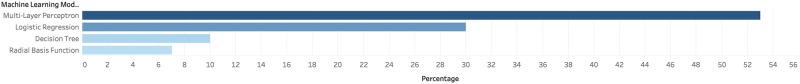
Distribution of machine learning classifier types for single-CpG feature models.The MLP was selected most frequently in the single-input case (53%), followed by Logistic Regression (30%), Decision Trees (10%), and Radial Basis Functions (7%). As the number of features per model increased, the MLP classifiers tended to further dominate the classifier selection process, with 86.67% of the twelve-feature classifiers attaining highest cross-validation accuracy with the MLP.